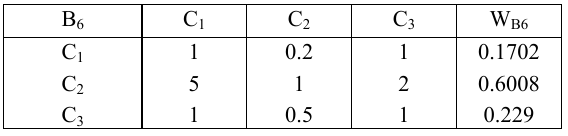
Table 7. The pairwise comparisons matrix C 1-3 –B 6